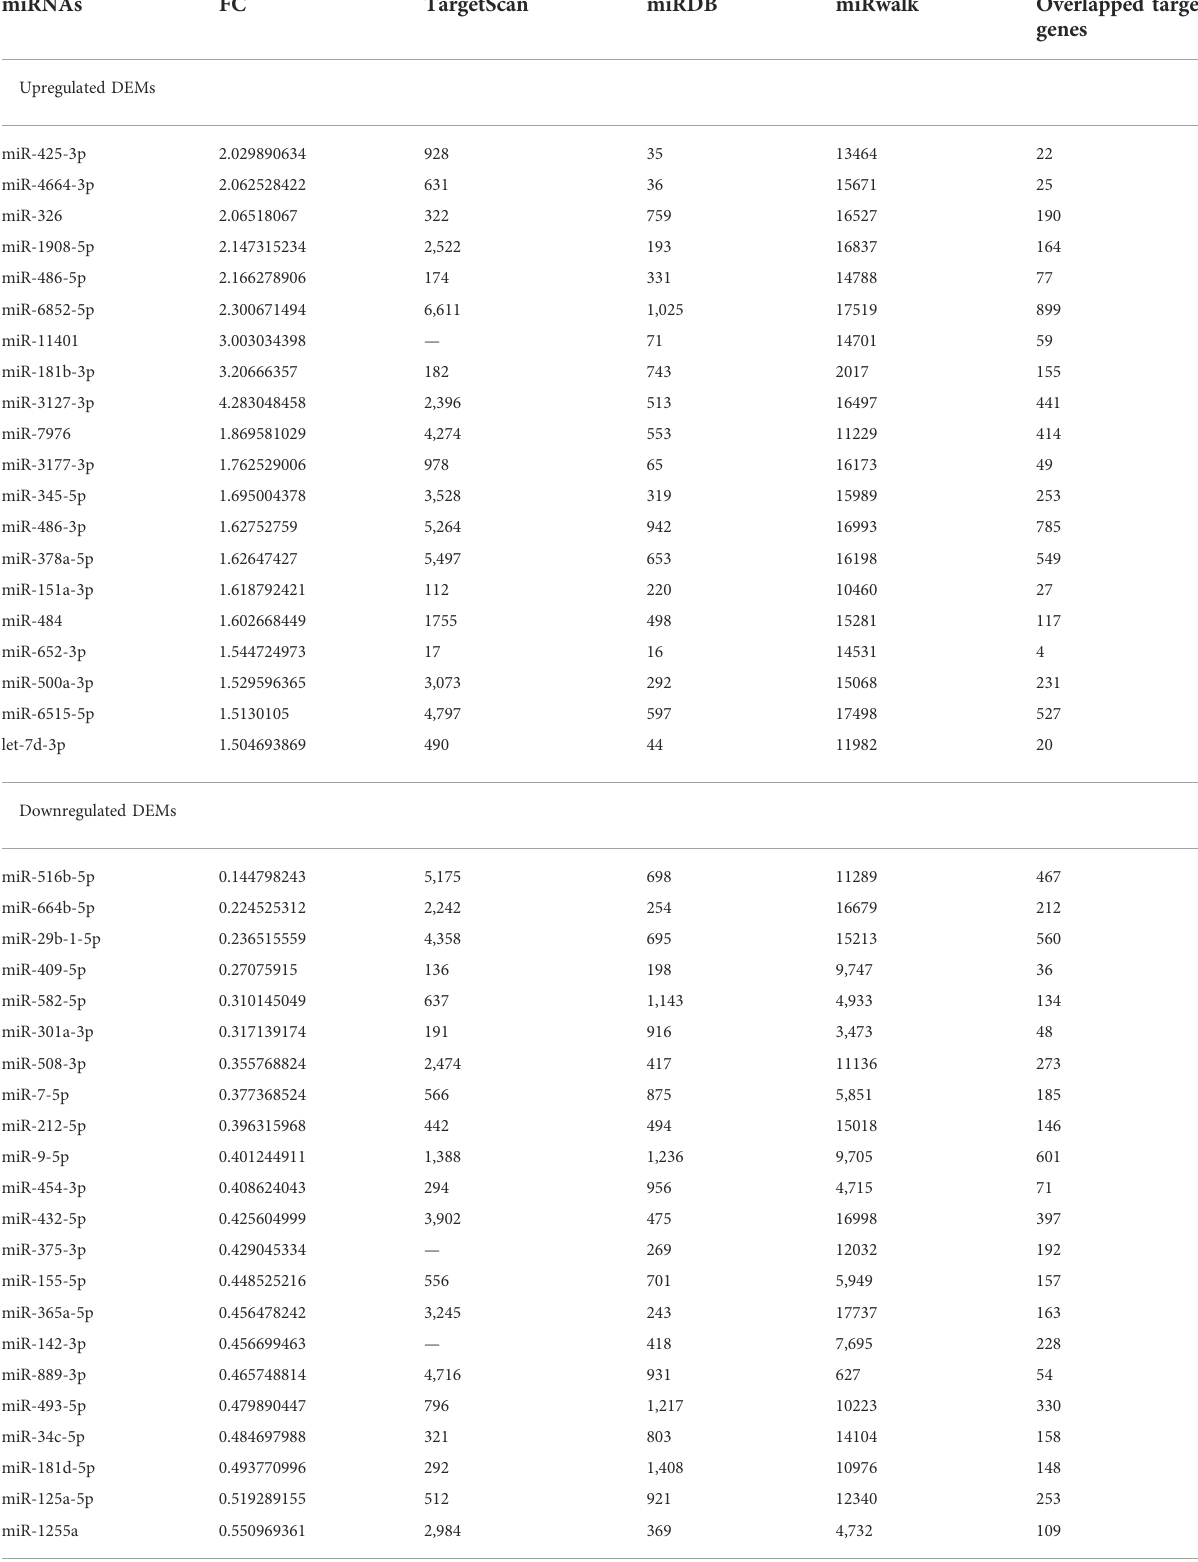
TABLE 2 miRNAs ’ Fold Change and miRNA-target genes count. miRNAs FC TargetScan miRDB miRwalk Overlapped target